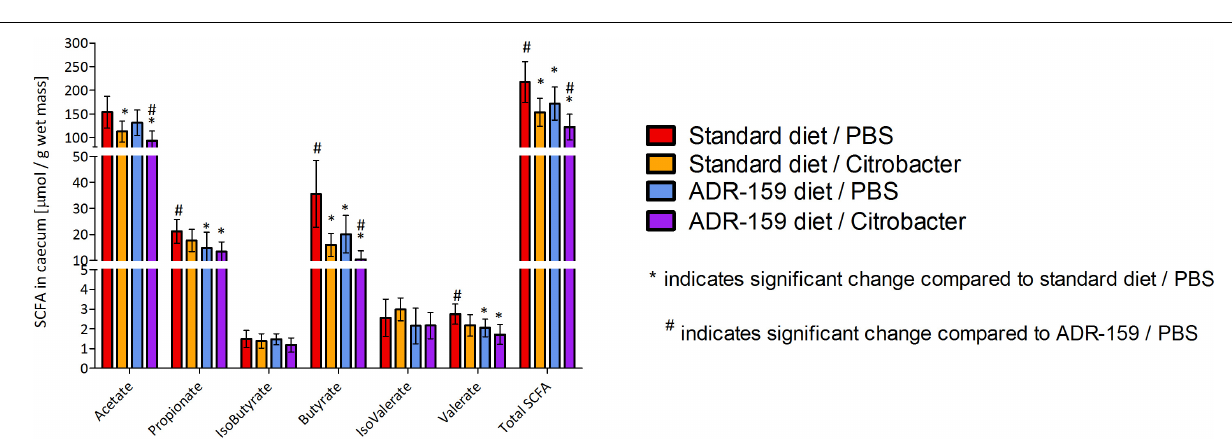
FIGURE 7 | SCFA concentration in cecum of standard (red, orange) and ADR-159 (blue, purple) fed animals dosed with PBS (red, blue) or C . rodentium (orange, purple). Error bars represent SD. *Indicates significant change compared to standard diet/PBS, # indicates significant change compared to